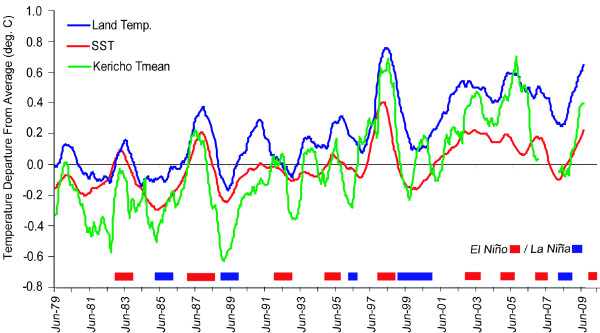
Time series of monthly departures from 1980-2009 mean values (deg. C) with an 11-month moving average applied for Kericho Tmean (green line), global tropical SST (25S-25N) (red line) and tropical land area mean temperature (blue line). Color bars at the bottom of the figure show the occurrence of El Niño and La Niña events (based on the definition in use at the US Climate Prediction Center). See Table 2 for temporal correlations between these variables